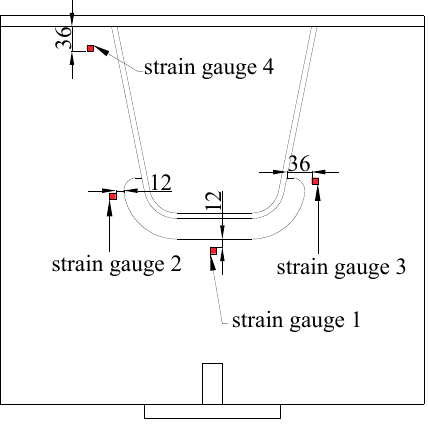
Figure 7. Strain gauge arrangement. The strain was converted, and the comparisons between tests and the FE model are shown in Figure 8.